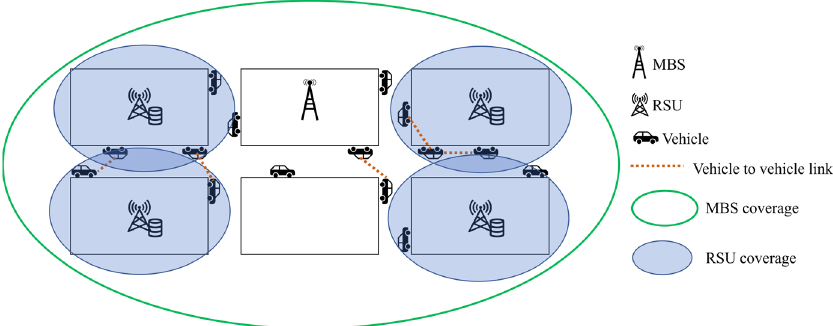
Figure 1. Caching framework in the vehicular network with different types of caching nodes.